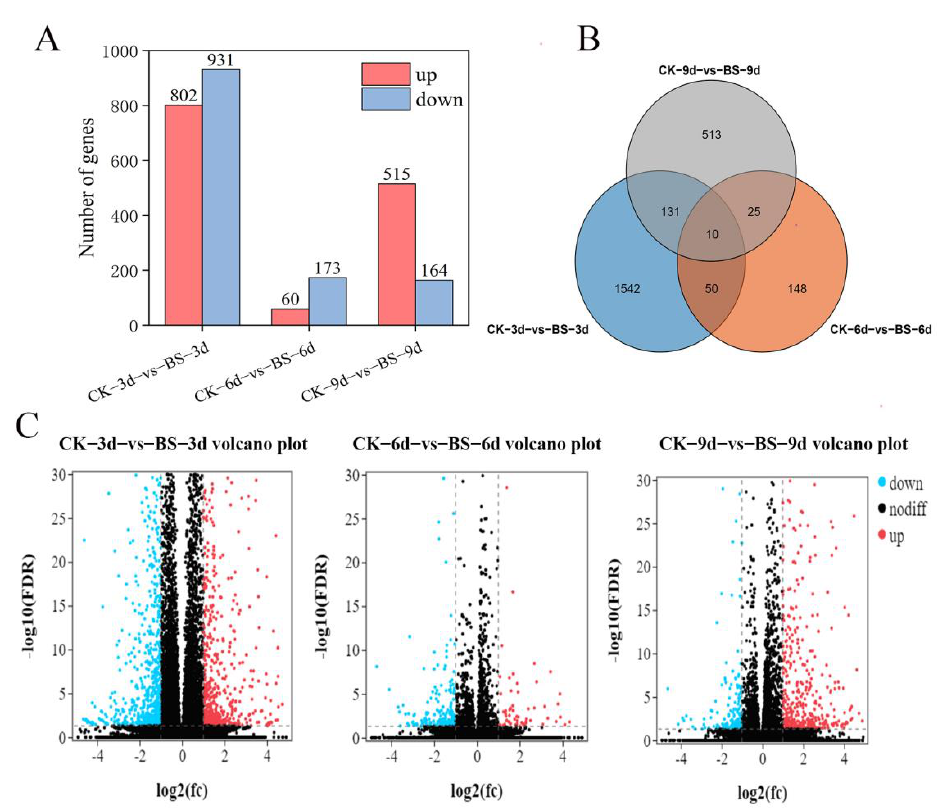
Figure 4. Analyze the different expressed genes in the three comparison mango fruit groups. ( A ) Bar chart of the number of DEG in three groups. ( B ) Venn diagram of DEGs among three different comparisons. ( C ) Volcano plot of DEGs.